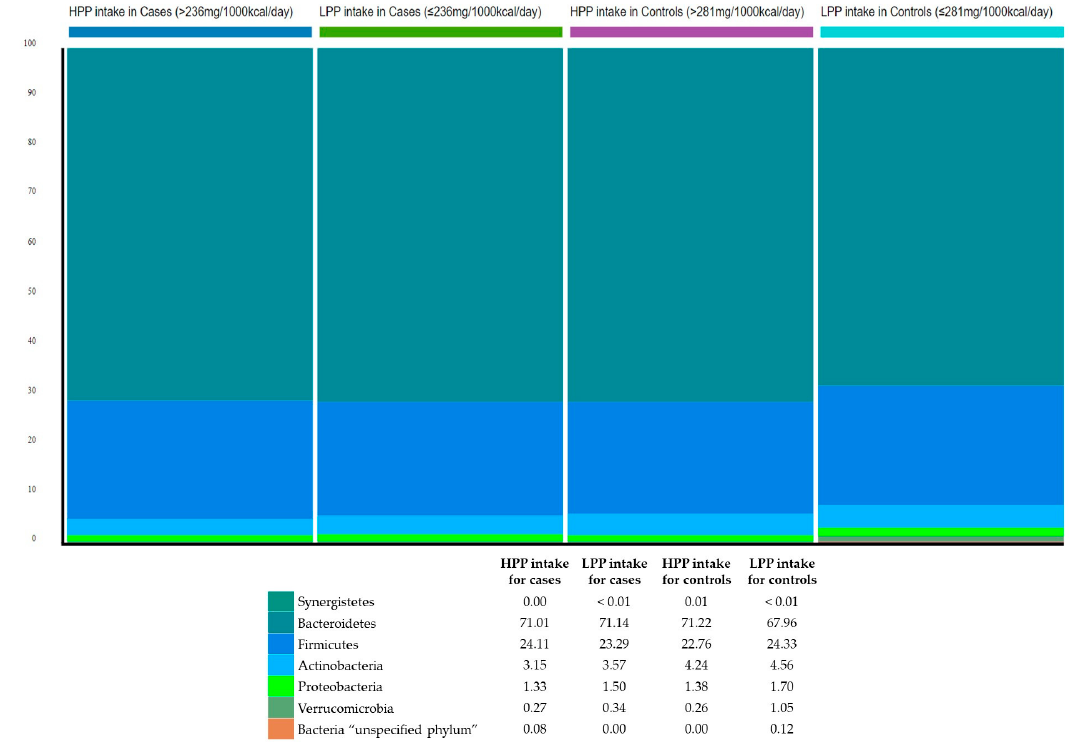
Figure 1. Phylum-level classification of gut microbiota according to categories of polyphenol intake and relative to BMI. HPP, high polyphenols; LPP, low polyphenols. Among those with low polyphenol intake, the Shannon – Wiener index revealed that the control group had a higher α -diversity than the case group ( p = 0.02) (Figure 2). Similarly, the α -diversity was higher in the normal compared to the high WHR group with low polyphenol intake ( p = 0.05) (Figure 3).